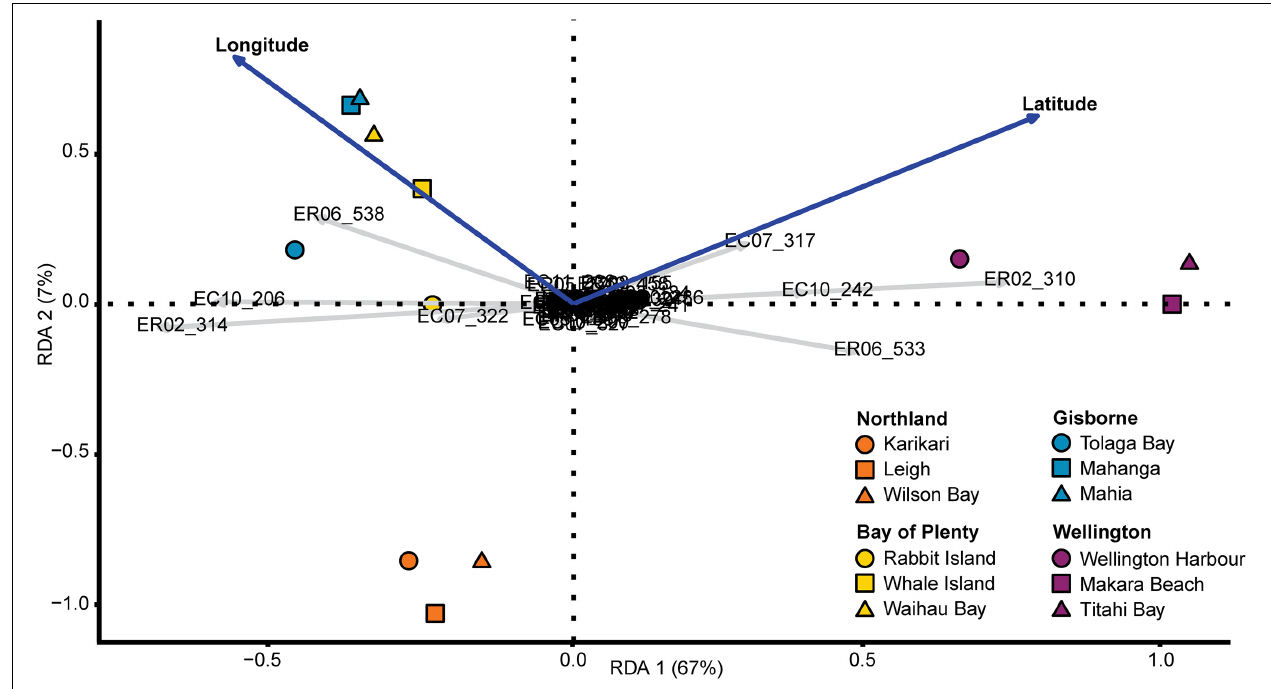
FIGURE 4 | Redundancy analysis (RDA) of allele frequencies explained by geographical location (longitude and latitude). Gray vectors with allele names indicate magnitude and direction of the variation associated with each identified allele where the vector length indicates the amount of variation and the vector direction indicates the correlation of the variation with the two RDA axes (parallel lines being highly correlated). Similarly, the blue vectors indicate the magnitude and direction of the variation associated with the latitude and longitude coordinates of the sites. Sites are plotted according to region (color) and position within region (shape). The percent variation explained by the two RDA components are shown on the two